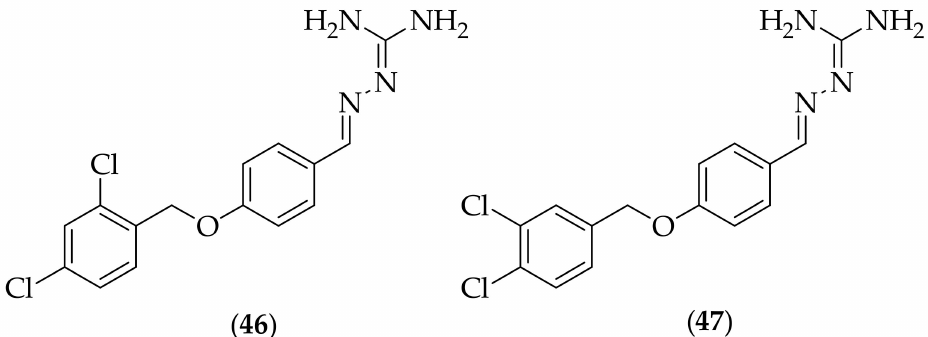
Figure 30. Aminoguanidine-containing antifungal compounds ( 46 ) and ( 47